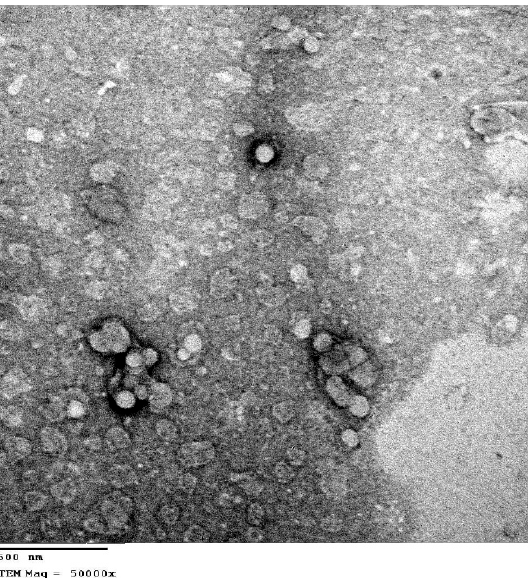
Figure 2. Transmission electron micrograph of the optimized formula of the zolmitriptan-loaded spanlastic.